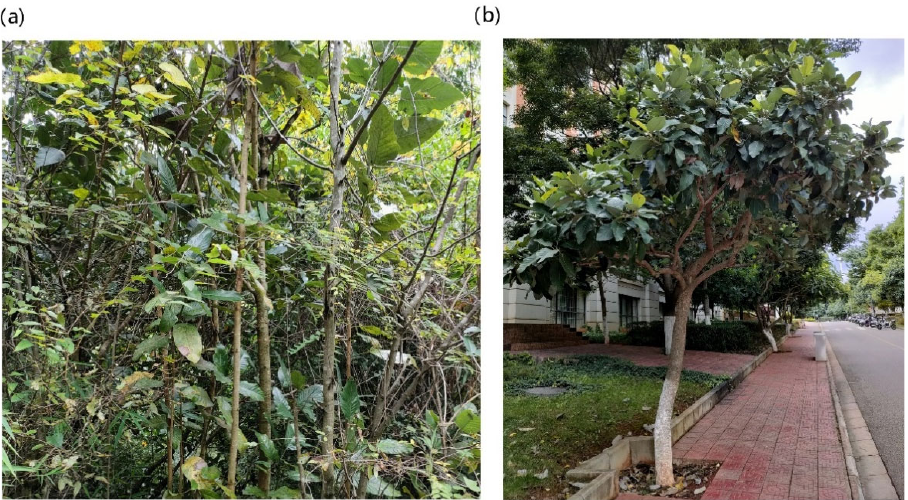
Figure 1. Habitats for representative L. delavayi individuals grown in the wild ( a ) and on campus ( b ) in Yunnan Province. The GPS coordinates are given in Table S1.